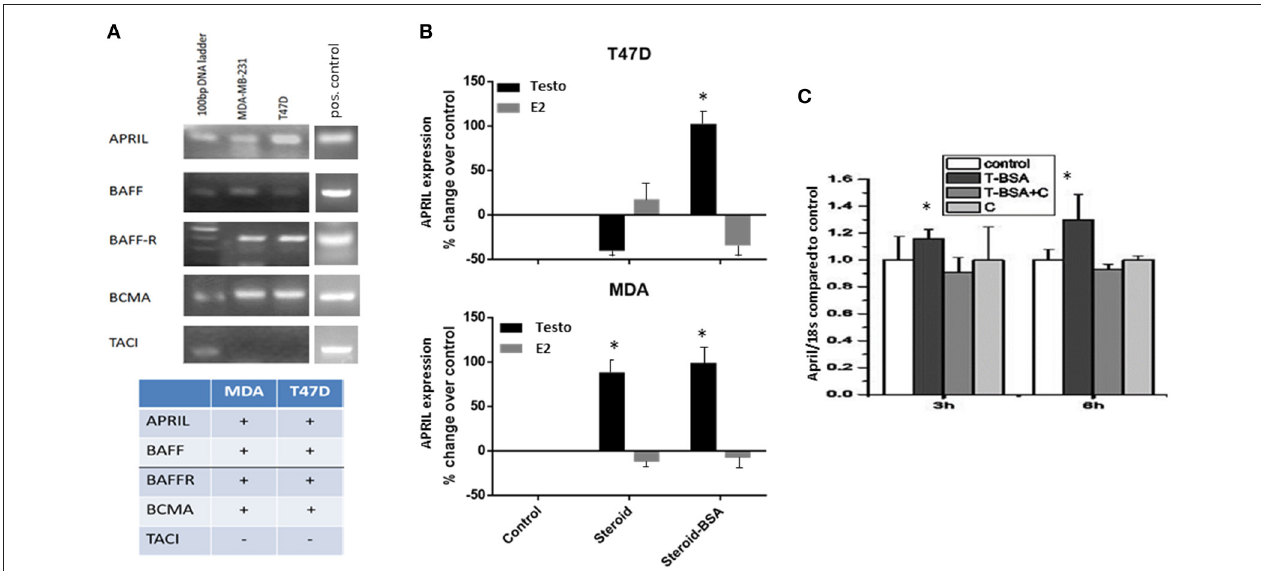
FIGURE 1 | Expression levels of BAFF, APRIL, BAFF-R, BCMA, and TACI in breast cancer cell lines and the effect of steroid hormones on APRIL expression levels (A) . The expression of BAFF, APRIL, BAFF-R, BCMA, and TACI investigated by PCR in T47D and MDA-MB-231 cells breast cancer cell lines. Figure presents the results of a single experiment, while table shows the presence or absence of transcripts, based on three different experiments. See Material and Methods for further details and description of the controls. (B) APRIL expression [from data previously reported ( 20, 21)] and deposited in GEO under the numbers GSE18146, GSE32666, and GSE32668) after treatment of breast cancer cells for 3h with steroid hormones, testosterone (Testo) or estradiol (E2), unconjugated or in their membrane impermeable form conjugated to BSA (steroid-BSA). See Material and Methods for details of data extraction and analysis. (C) Effect of testosterone-BSA (T-BSA) on APRIL expression (investigated by PCR) in T47D breast cancer cells in the presence or absence of cyproterone acetate (C) (*denotes p <